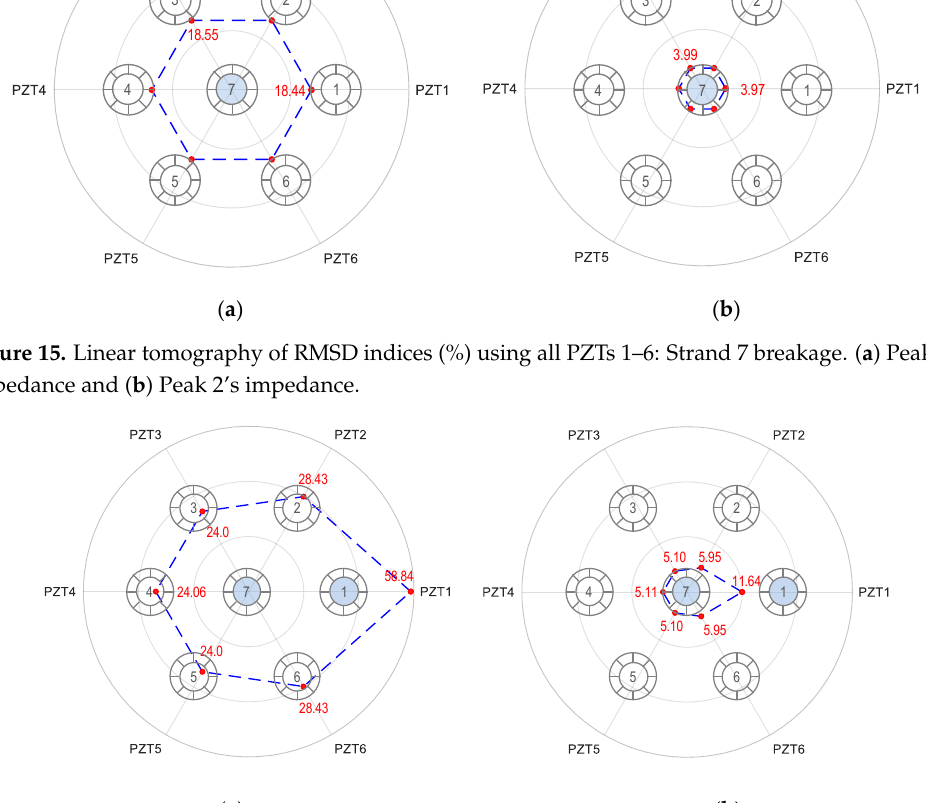
Figure 16. Linear tomography of RMSD indices (%) using all PZTs 1–6: Strands 1 and 7 breakage. ( a ) Peak 1’s impedance and ( b ) Peak 2’s impedance.